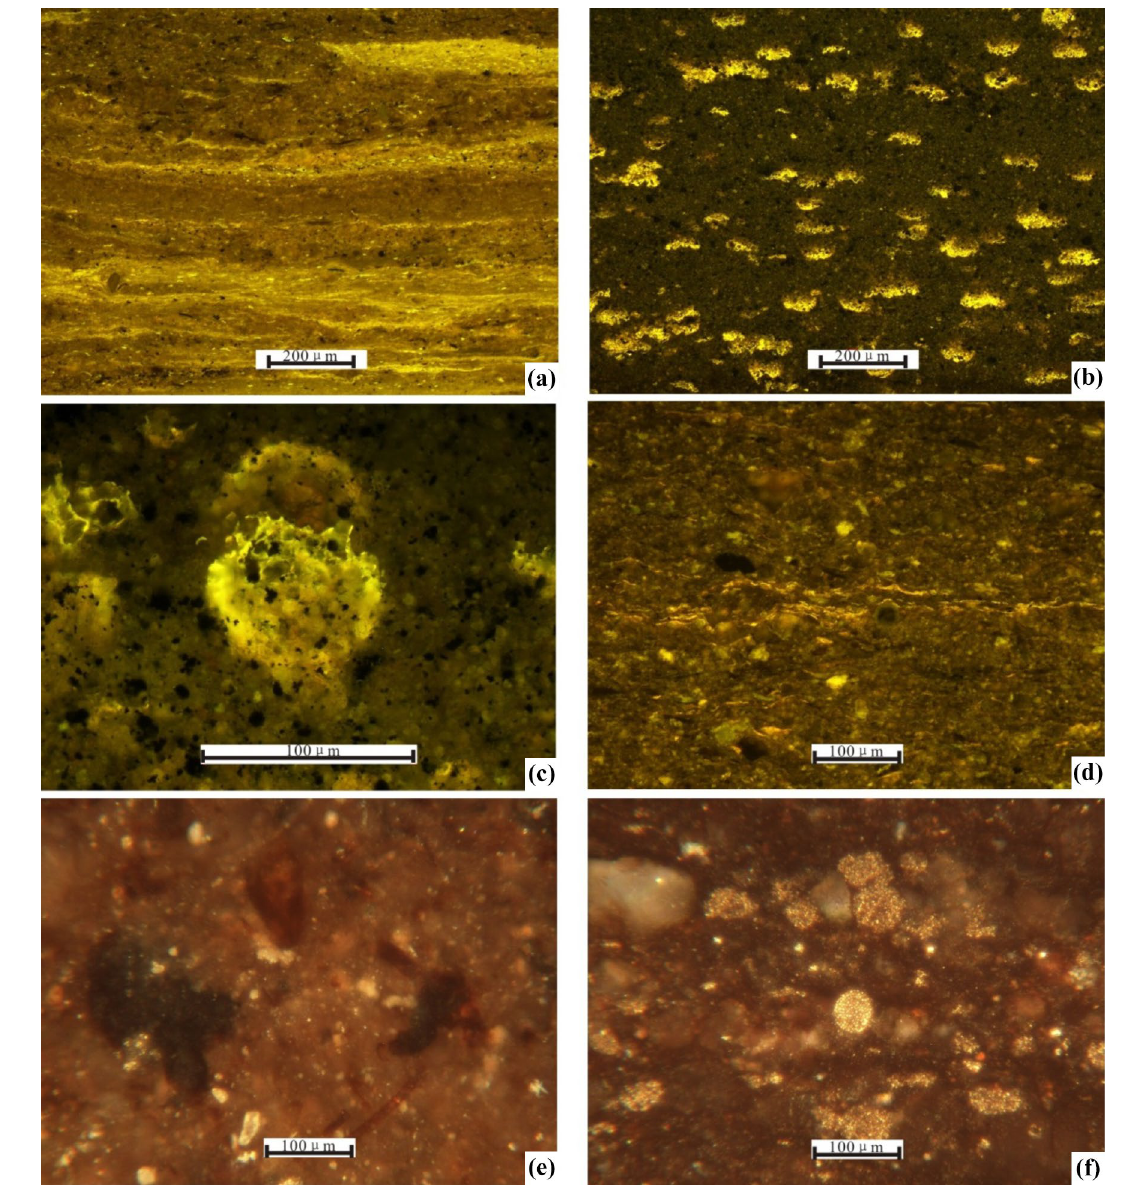
Fig. 4 Photomicrographs of organic matter from ORI 5 of well BYHF 1. a Lamalginite fluorescing moderate yellow with lamellar form, 2417.46 m; b, c bright yellow fluorescence-structured remains of algae associated with clay minerals, and show cell structure under